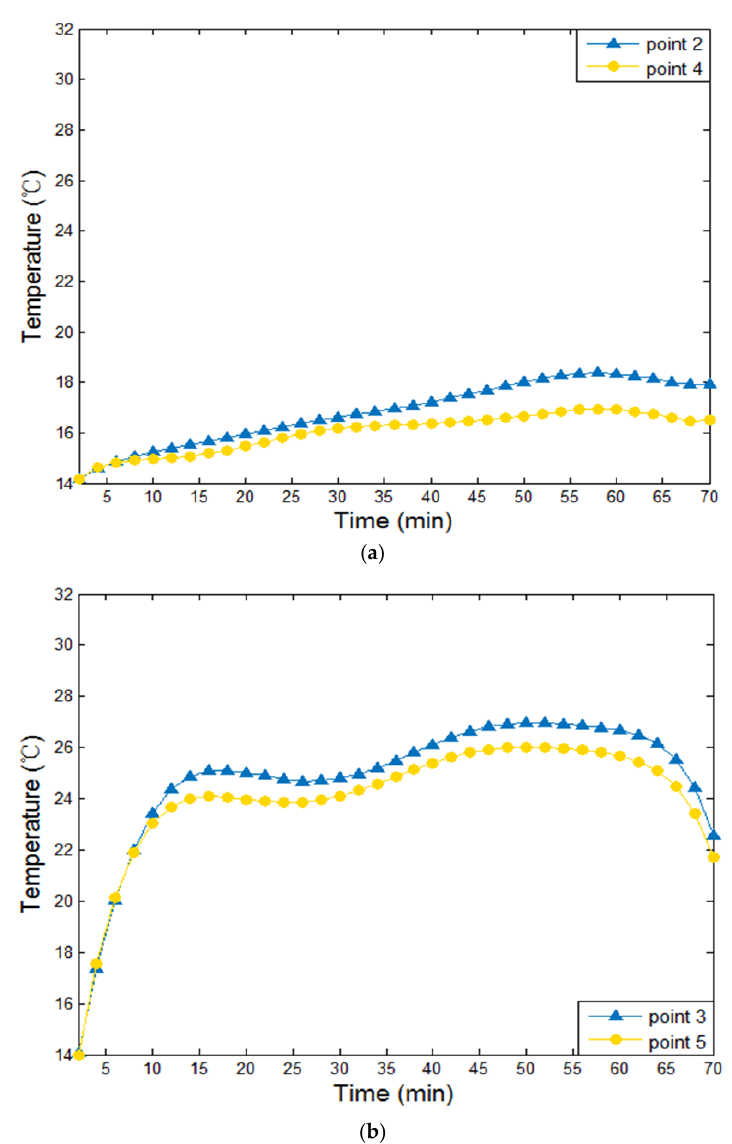
Figure 19. Temperature of the void boundary under lateral heating: ( a ) left side and ( b ) right side.